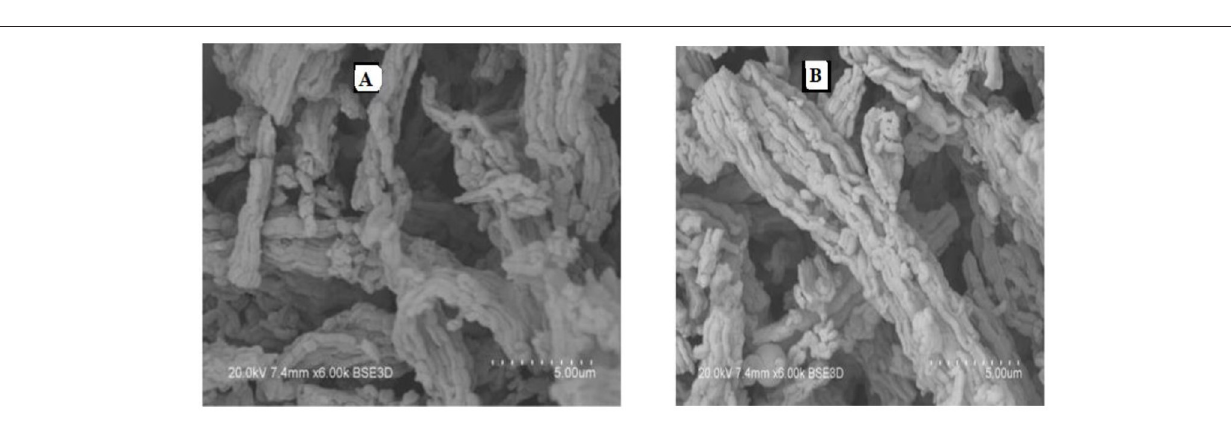
12COIMPNi11CoN-C and 4COIMPNi12LaN-B spent